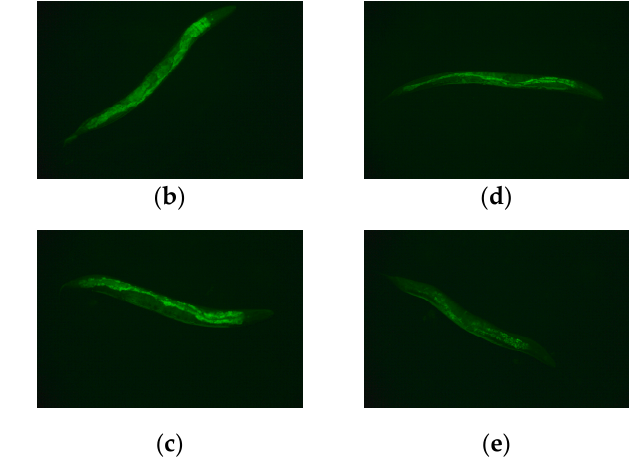
Figure 2. SH reduced senescence pigments in nematodes of the same age. Lipofuscin in nematodes is an auto-fluorescent pigment that can be observed by inverted fluorescence microscopy, and the accumulation of senescence pigments was analyzed by Image J software. ( a ) shows the relative fluorescence intensity of lipofuscin in each group of nematodes. ( b – e ) show the control group, and the 200 μ g/mL, 400 μ g/mL, 800 μ g/mL SH treatment groups, respectively, as observed under inverted fluorescence microscopy. Lipofuscin assays were carried out in triplicate. Notes: The asterisk (****) represents the significant difference; the larger the number, the more significant.